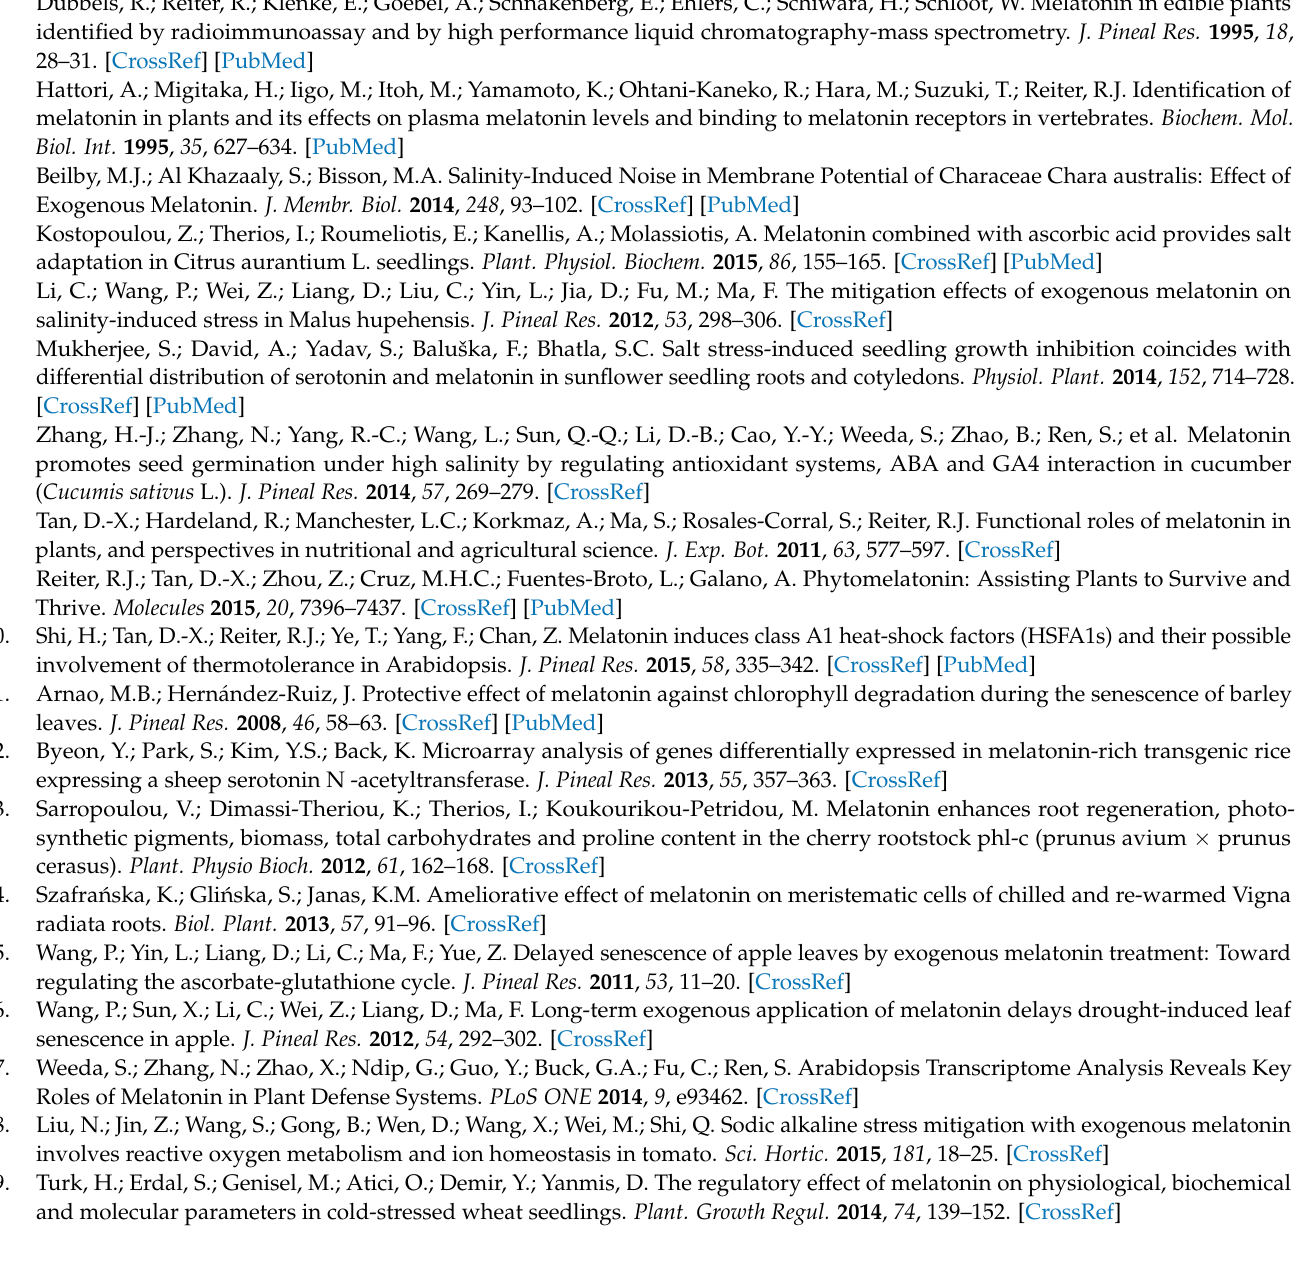
ultrastructure of tomato seedlings under salt